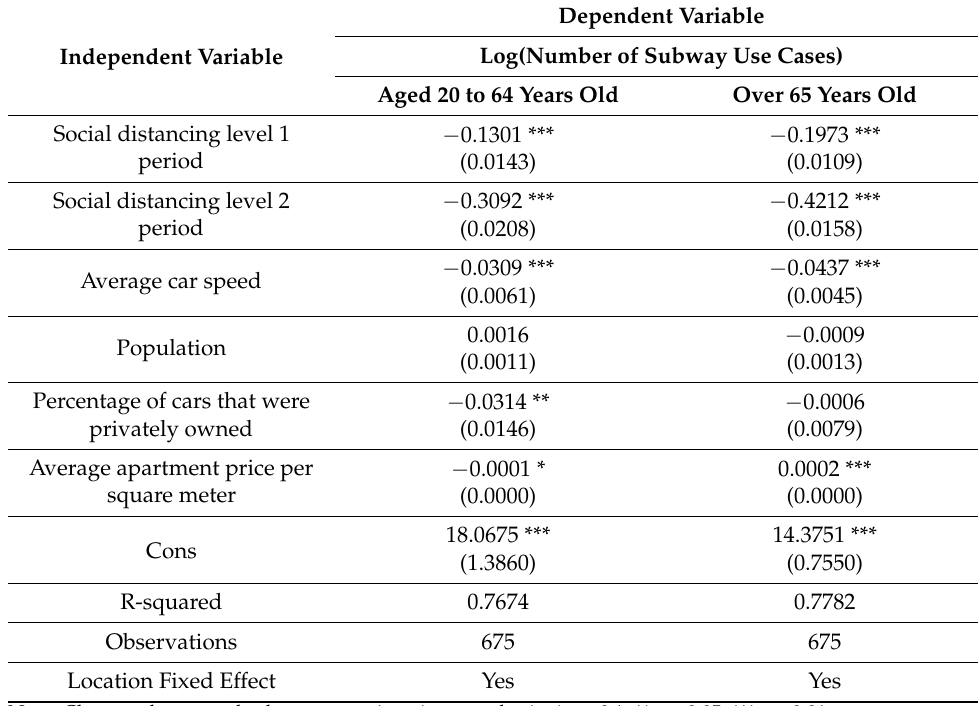
Table 1. Panel results: change in the subway demand by age and